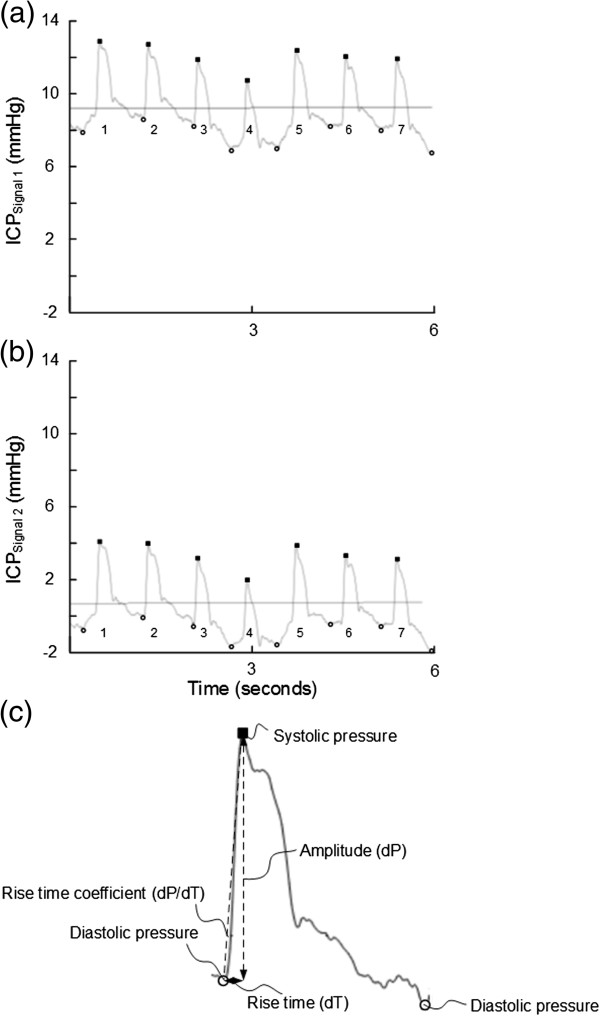
Simultaneous 6-sec time windows of signals 1 and 2. An example of a 6-sec time window showing the signal of (a) ICP Signal 1 and (b) ICP Signal 2. The 6-sec time window contains seven cardiac-induced ICP waves; the amplitude (dP), rise time (dT) and rise time coefficient (dP/dT) were automatically determined for each wave (c). The mean ICP (horizontal lines) and mean ICP wave amplitude (MWA) were determined for every consecutive 6-sec time window. For the 6-sec time window shown in a-b, the values were as follows: (a) Signal 1: Mean ICPSignal 1 9.0 mmHg, MWASignal 1 4.3 mmHg, MWRTSignal 2 0.23 sec, and MWRTCSignal 2 24.1 mmHg/sec. (b) Signal 2: Mean ICPSignal 2 0.3 mmHg, MWASignal 2 4.3 mmHg, MWRTSignal 2 0.24 sec, and MWRTCSignal 2 24.2 mmHg/sec. For this particular 6-sec time window, the BPE was represented by a difference in mean ICP of 8.7 mmHg, despite close to identical waveform, represented by difference in MWA of 0.05 mmHg, difference in MWRT of 0.003 sec, and difference in MWRTC of 0.14 mmHg/sec.